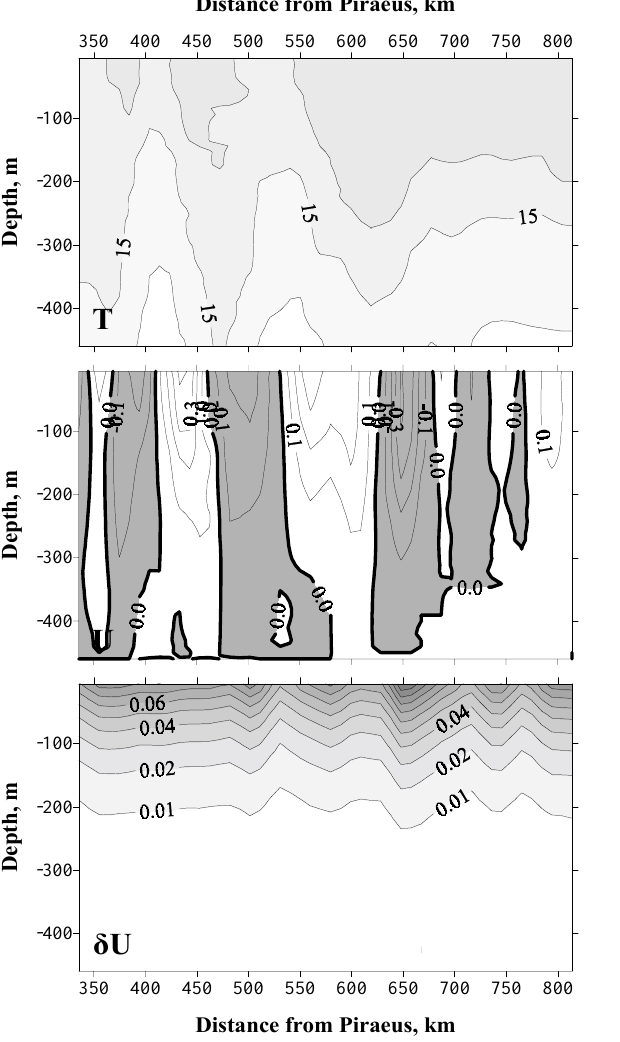
Fig. 7d. As in Fig. 7a, for the 10th crossing on 19 May 2000.